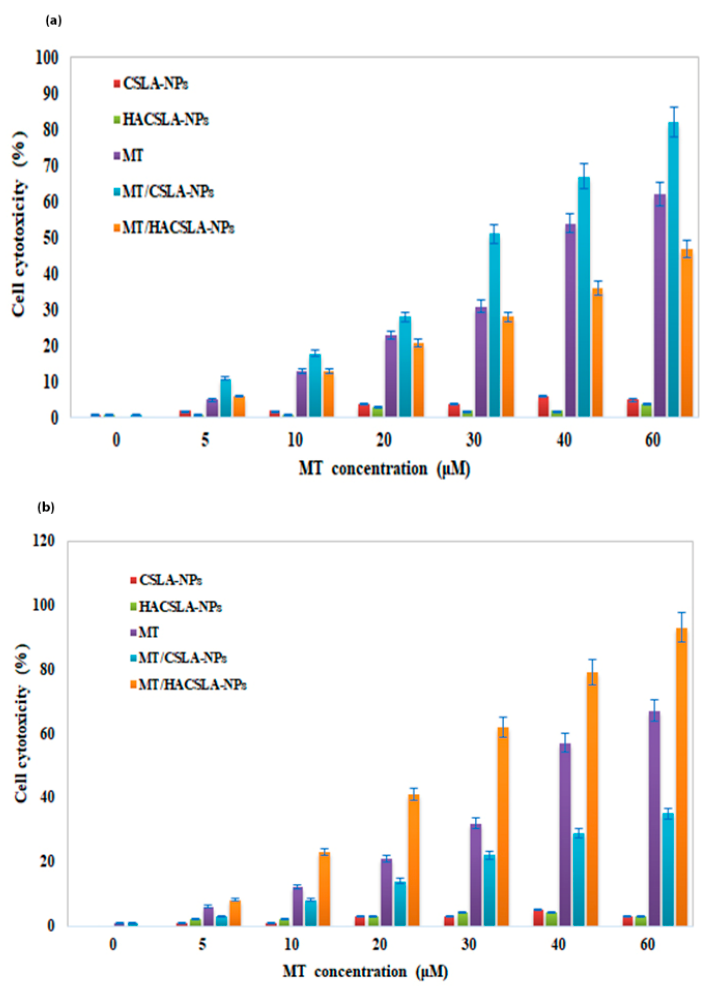
Figure 7. MT cytotoxicity measured with the LDH assay in ( a ) MCF-7 and ( b ) BT-20 cells. All data represented by mean ± S.E.M ( p < 0.05).